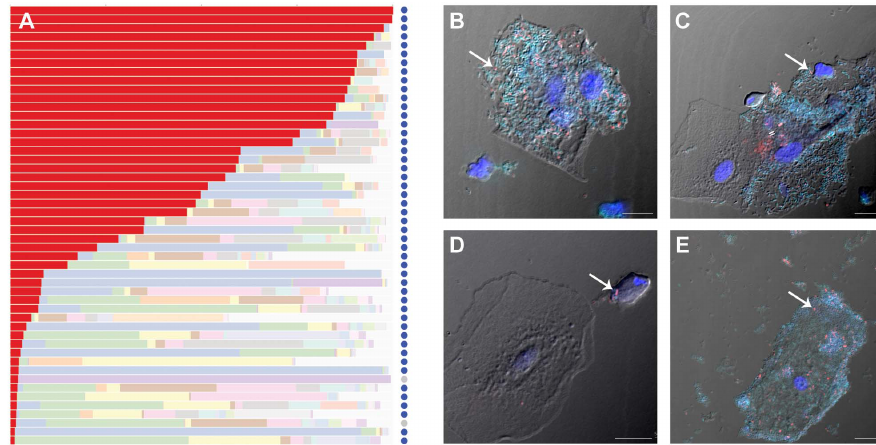
Figure 1. Detection of ‘‘ Ca . Mycoplasma girerdii’’ in mid-vaginal samples. Panel (A) shows relative abundance of major taxonomic groups in ‘‘ Ca . M. girerdii’’ positive samples (1% 16S rRNA threshold): ‘‘ Ca . M. girerdii’’ is colored red (A). Light colored bars represent other taxa. Dark blue circles represent samples positive for T. vaginalis by qRT-PCR, light gray circles represent negative samples. Panels (B–E) show fluorescence in situ hybridization detection of bacteria in mid-vaginal samples from two participants with clinically diagnosed trichomoniasis (subject 1, panels B, C and D; subject 2, panel E) by confocal laser scanning microscopy. Most bacteria were detected with fluorescein-labeled broad-range bacteria probe Eub338 (turquoise). ‘‘ Ca . M. girerdii’’ was also stained with a Cy5-labeled probe targeting 16S rDNA (red). Nuclei were labeled with 4 9 6 9 -diamidine-2- phenylindole, dehydrochloride (DAPI, blue). Negative control with reverse complementary probe of Eub338 did not hybridize to any bacteria (data not shown). Scale bar=10 m m.